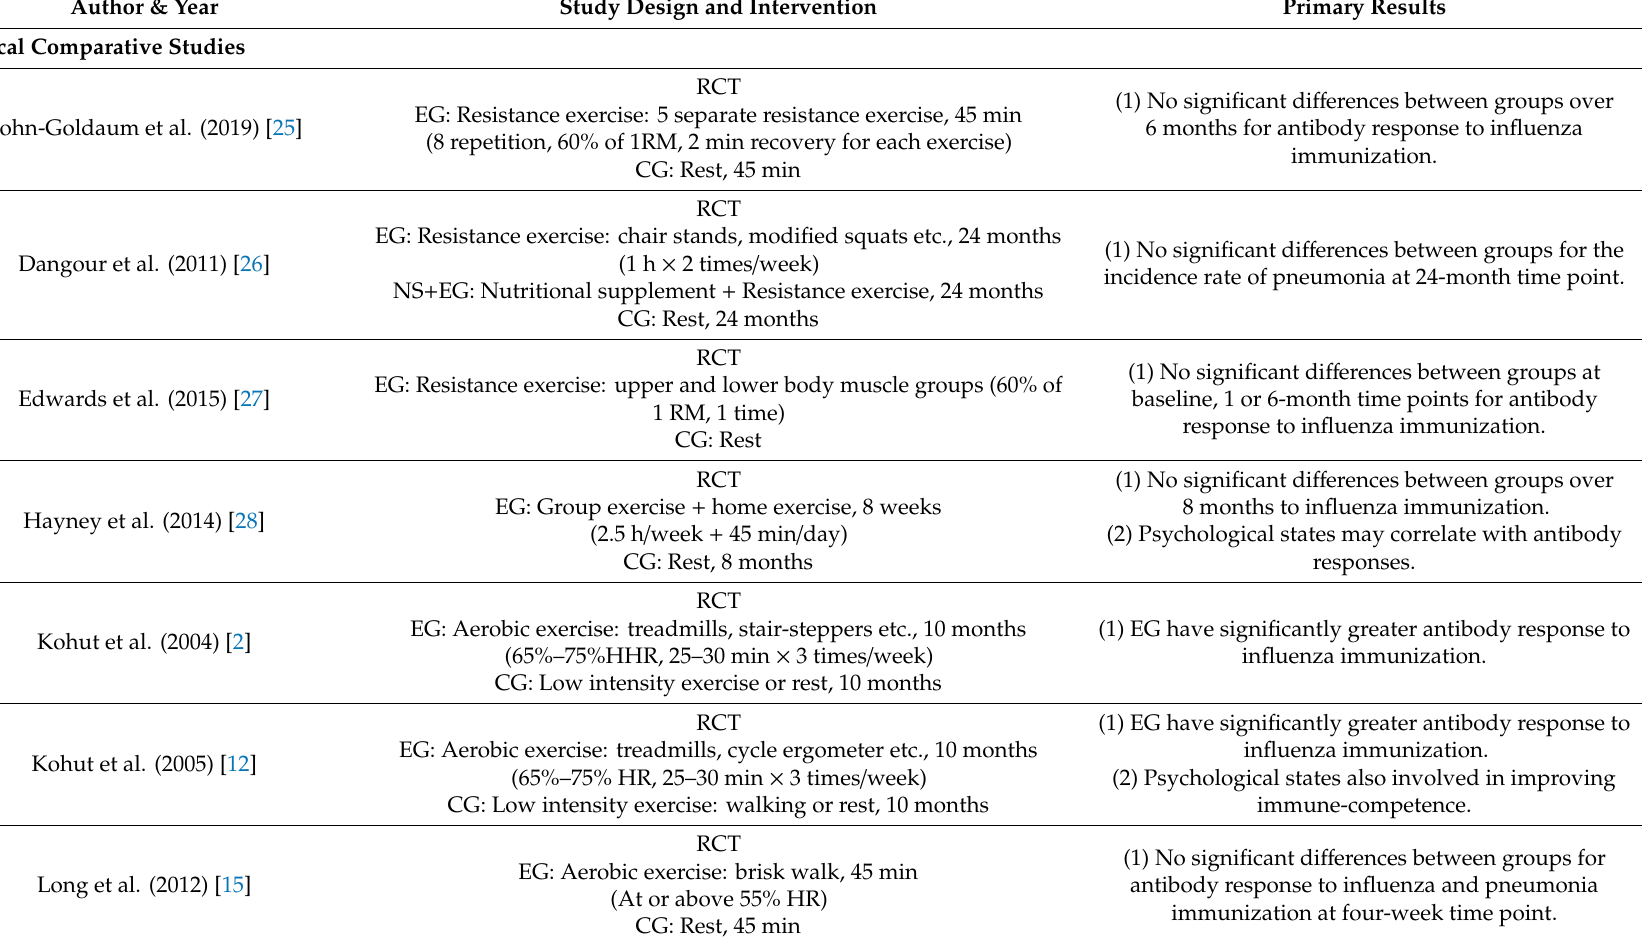
Table 3. The main findings of